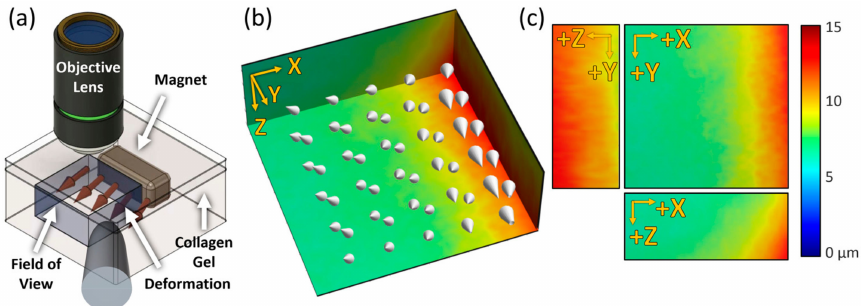
Figure 4. Mechanical stimulus using a magnet on the collagen gel and its visualization. ( a ) Schematics of applying an arbitrary force on the collagen gel. The blue cube indicates the imaging field of view. ( b ) The absolute magnitude of displacements depicted with a color-coded map and cone arrows over the field of view. ( c ) The magnitude of deformation for each axis (U corresponds to the X -axis, V corresponds to the Y -axis, and W corresponds to the Z -axis. Field of view is 224 × 224 × 130 µ m 3 ).